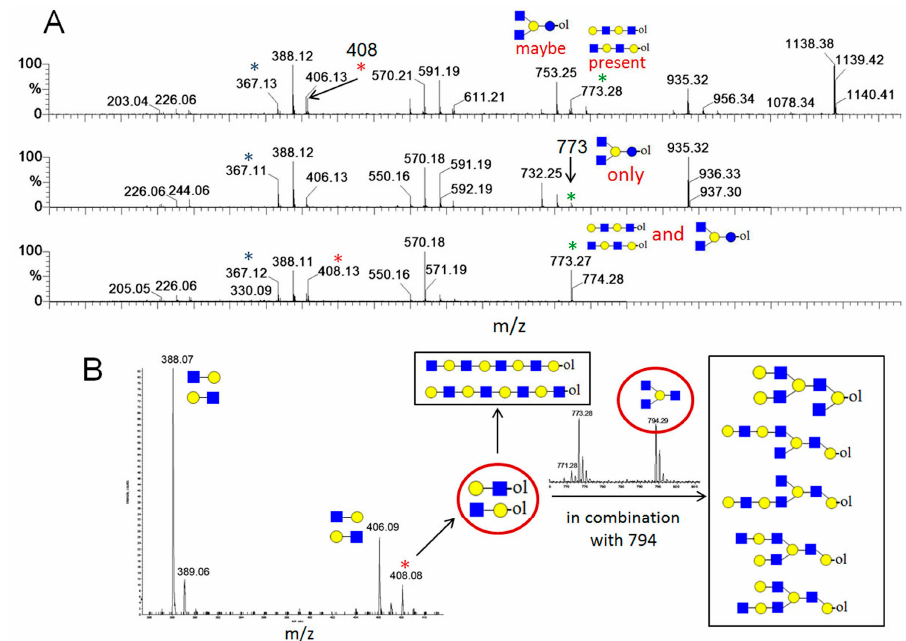
Figure 9. The assignment of CID (collision-induced dissociation) MS data using diagnostic ( m / z = 367 and 794 Da) and conditional diagnostic ( m / z = 408 and 773 Da) product ions. ( A ) MS/MS spectra of the precursor ions at m / z = 773, 935 and 1138 Da; ( B ) Zoom-in of the mass range of 385–410 and 770–800 Da. Possible structures are all in accord with the fragmentation pattern. denotes N -acetylglucosamine, galactose and glucose. *, * and * denote ions relevant to the explanation in the text. Reproduced from [49]. Copyright MDPI, 2014.